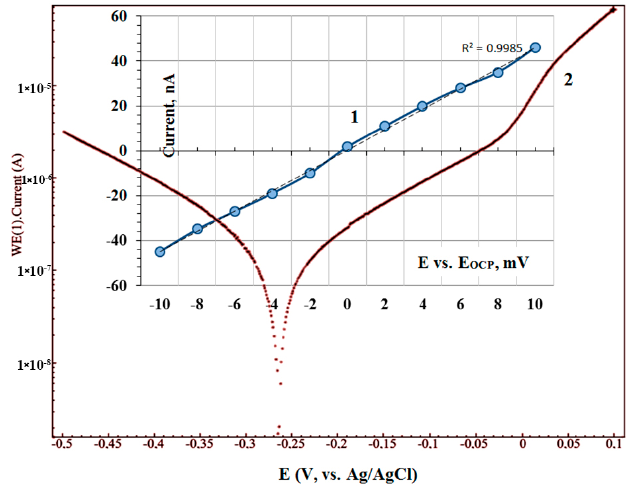
Figure 7. Linear sweep voltammogram of Ti/PAAT/Ni sample after stabilizing the free potential of corrosion (2). In the insert—a small part of this voltammogram within the potential range from − 10 to 10 mV (curve 1). 10 mV (curve